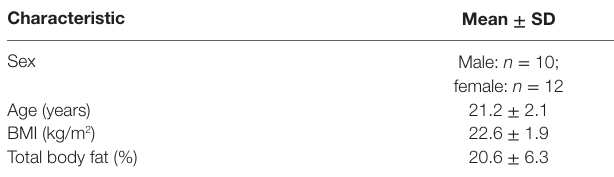
Table 1 | Participant characteristics ( n = 22).